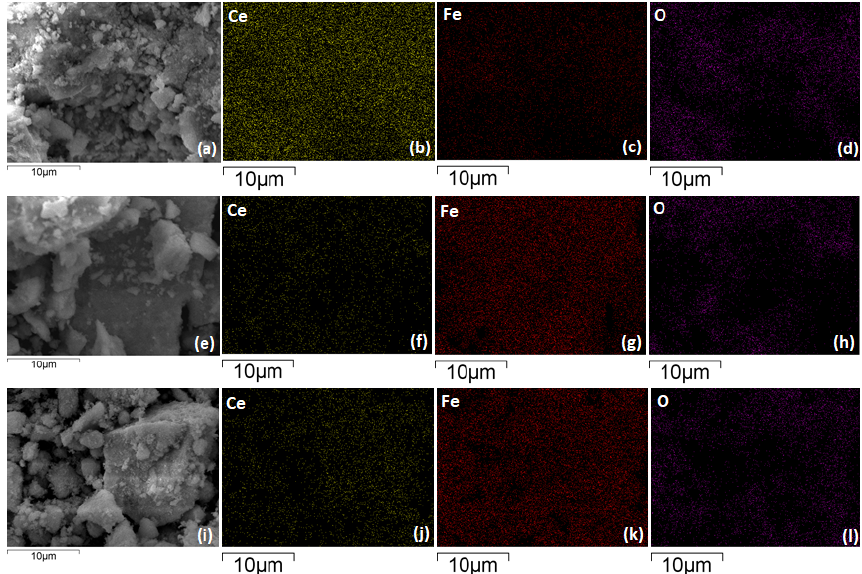
Figure 4. SEM ‐ EDS elemental mapping images of the samples: ( a–d ) Fe 2 O 3 /CeO 2 ‐ NR, ( e–h )